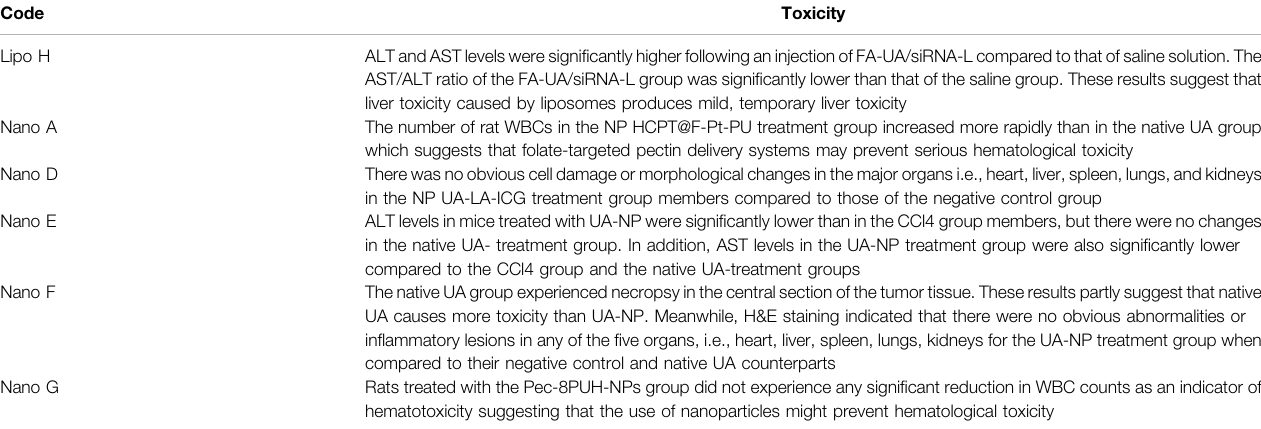
TABLE 6 | The relative body weight of animal models treated with UA-loaded nanoparticles compared to negative control and native UA-treatment groups. Code